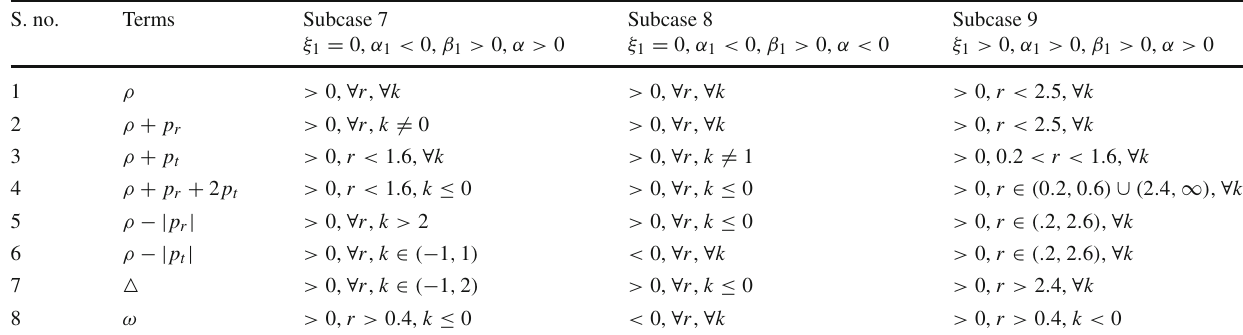
Table 2 Results for Model-I: ρ = α 1 R + β 1 R (cid:2) e ξ 1 R S.